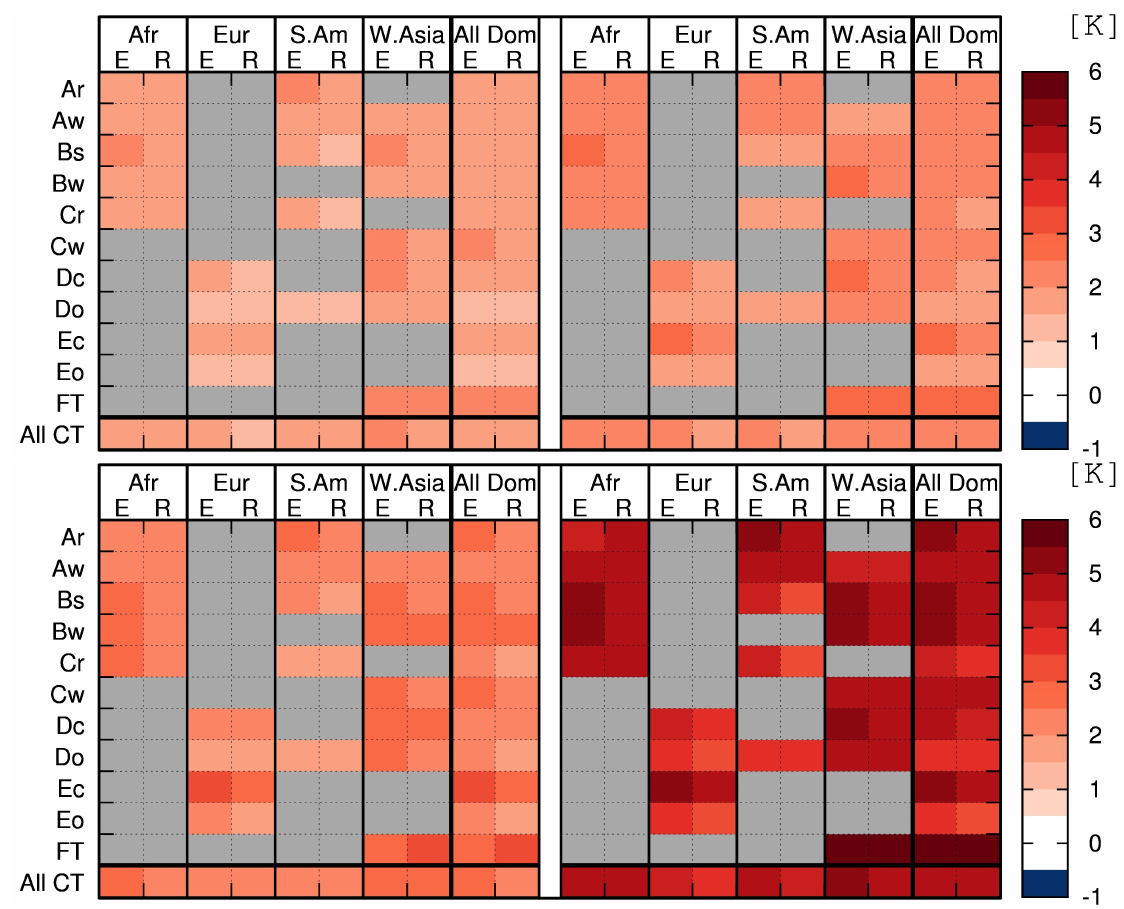
Figure 4. Climate change signals for each domain and each climate type for annual mean temperature. The climate change signals are depicted for temperature for RCP 4.5 (upper plot) and for RCP 8.5 (lower plot) considering only gridboxes for one specific climate type per region. Climate change signals as simulated by MPI-ESM (LR) (E) and REMO (R) are plotted on the left-hand side and on the ride-hand-side, respectively. The time periods considered are 2036–2065 (left panel) and 2071–2100 (right panel) compared to the time period 1971–2000. Climate types that are not present in the respective domain are depicted in